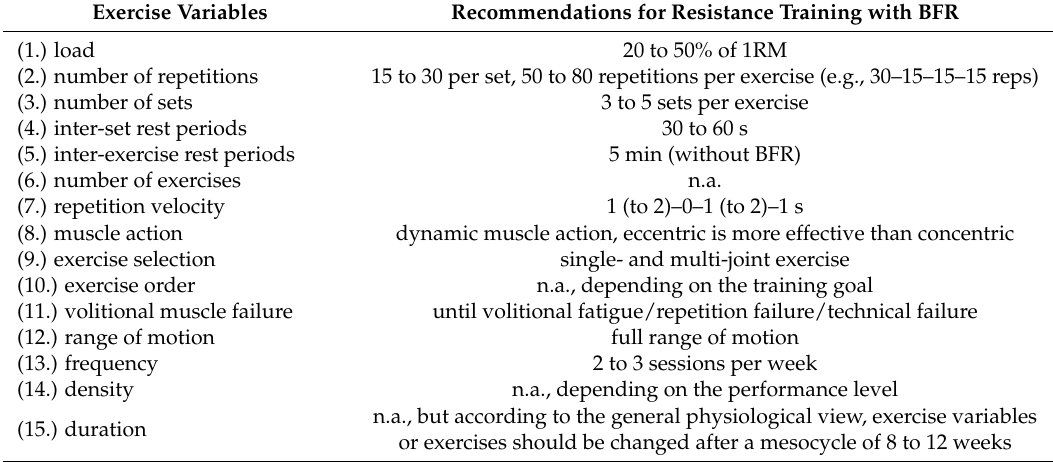
Table 1. Recommendations for exercises variables for a resistance training with blood flow